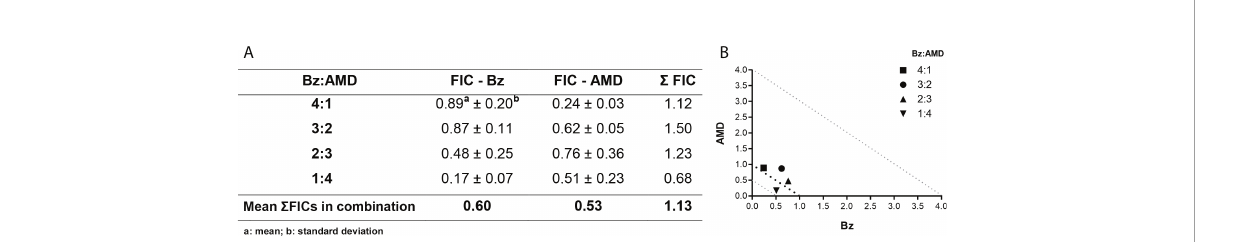
FIGURE 6 Effect of the combination Bz + AMD on intracellular forms of T. cruzi , after 72 h of treatment, demonstrating the addictive interaction (0.5 < S FICs ≤ 4.0). (A) Table showing the mean S FICs of the interaction at the drug ratios tested; (B) Isobologram plotted with the FIC of AMD and Bz on the abscissa and the ordinate, respectively.